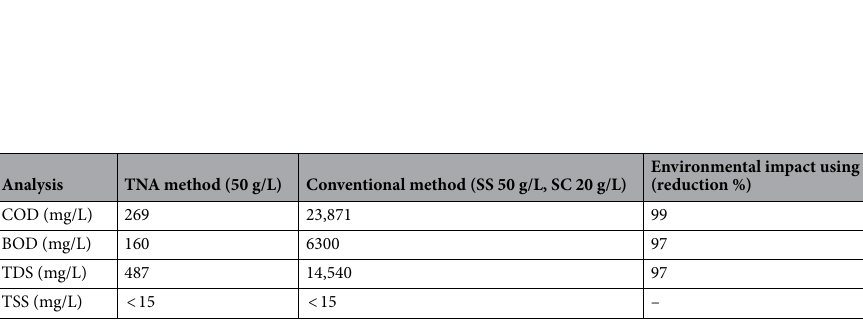
Table 4. Dye effluent analysis of the dye bath after dyeing cotton fabric with RY 145 for the conventional method using SS 50 g/L, SC 20 g/L compared with 50 g/L TNA method.